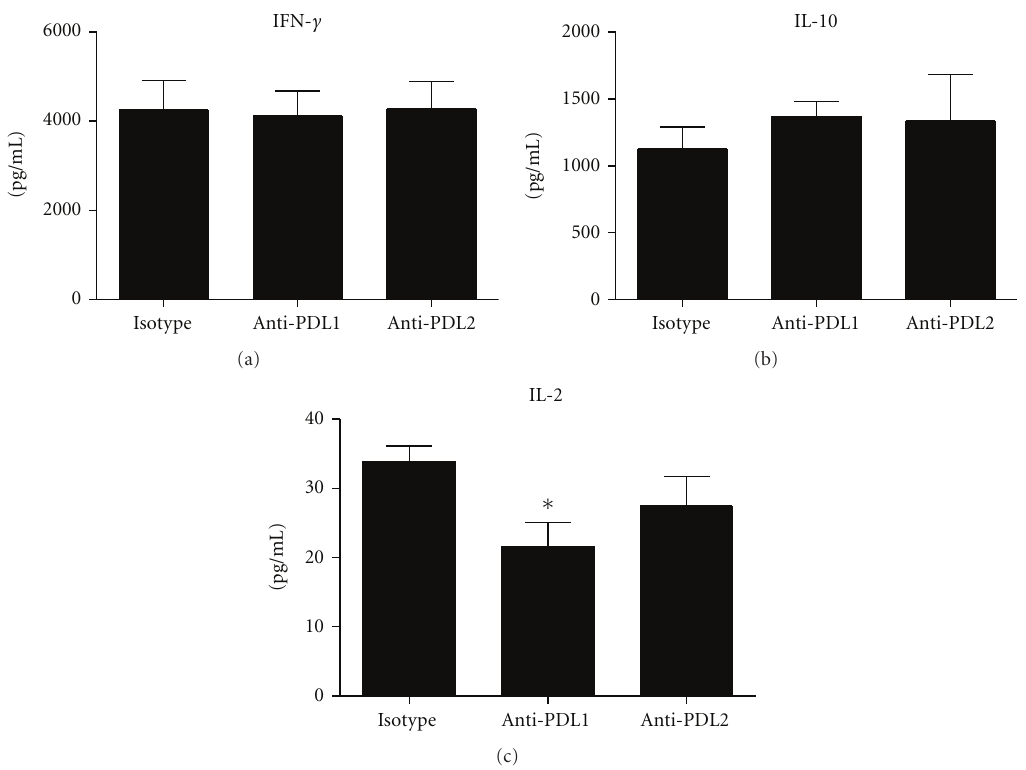
Figure 5: Functional analysis of MLN CD11c + cells following HSV-1 infection and treatment with anti-PD-L1 or anti-PD-L2 antibody. C57BL/6 mice were infected with 1,000 PFU HSV-1/cornea. At days 2, 4, and 6 p.i. mice were administered neutralizing antibody to PD-L1, PD-L2, or control IgG. At day 7 p.i. the mice were exsanguinated and CD11c + cells were highly enriched from the MLN. CD11c-enriched MLN cells were pulsed with UV-inactivated HSV-1 and cocultured with HSV gB-specific T-cell receptor T cells of transgenic mice. Following incubation, the supernatants were removed and assayed for IL-2 (a), IL-10 (b), and IFN- γ (c) levels by suspension array. Background cytokine levels were determined using nonpulsed CD11c + -enriched MLN cells. Background levels of cytokine production were subtracted from corresponding UV-inactivated HSV-1-pulsed samples. This figure summarizes two experiments ( n = 6). Each bar represents the mean ± SEM. ∗ P < 0 . 05 comparing the indicated group to the isotypic control antibody-treated